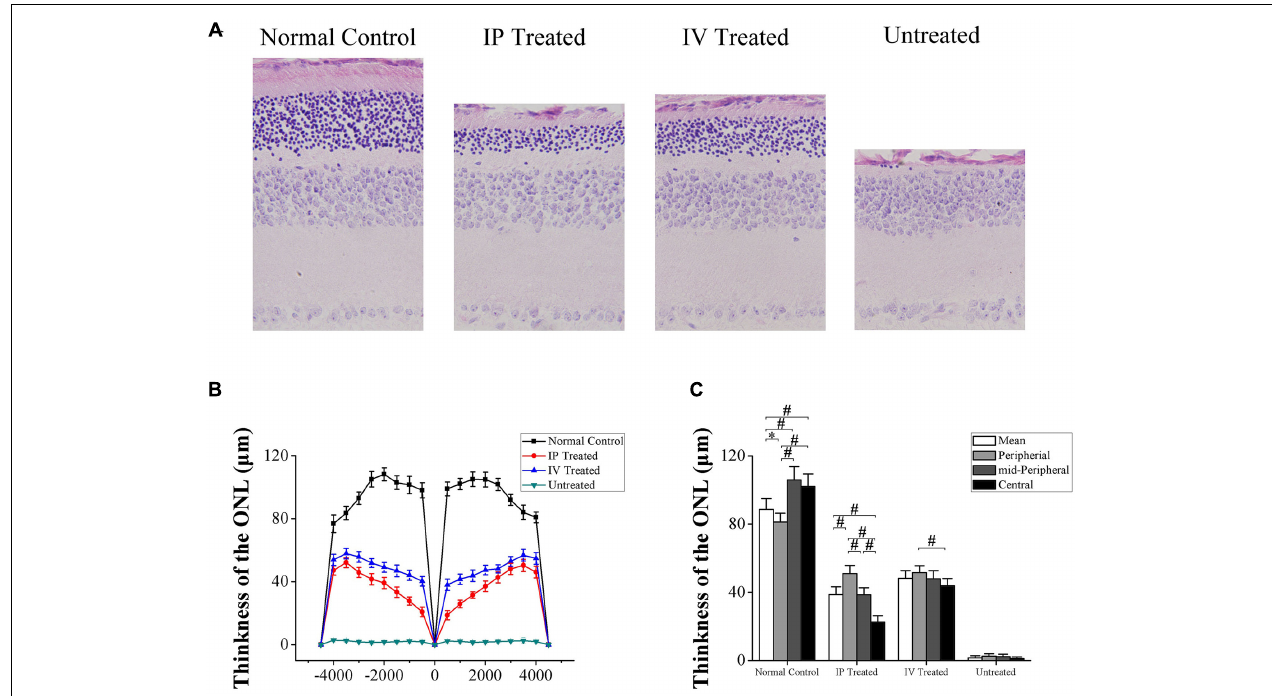
FIGURE 3 | Hydrogen rich saline induced effects on the retinal morphology of MNU administered rats. (A) The ONL architecture in the untreated group was terribly destroyed by MNU administration. Meanwhile, the photoreceptor in the IP and IV treated group were effectively rescued. (B) The ONL thickness of the IV treated group was ubiquitously larger than the IP treated group in the central, mid-peripheral, and peripheral regions. (C) The mean ONL thickness of the untreated group decreased significantly compared with the normal controls ( P < 0.01); the mean ONL thickness of the IV treated group was significantly larger than the IP treated group ( P < 0.01). The ONL thickness in the central region of the IP treated group was significantly smaller than the peripheral and mid-peripheral regions ( P < 0.01); the ONL thickness of in the mid-peripheral region was significantly smaller than the peripheral region ( P < 0.01). In IV treated group, the ONL thickness in the central region was significantly smaller than the peripheral region ( P < 0.05) (All the values were presented as mean ± SD; ∗ P < 0.05, # P < 0.01 for differences compared between the animal groups).